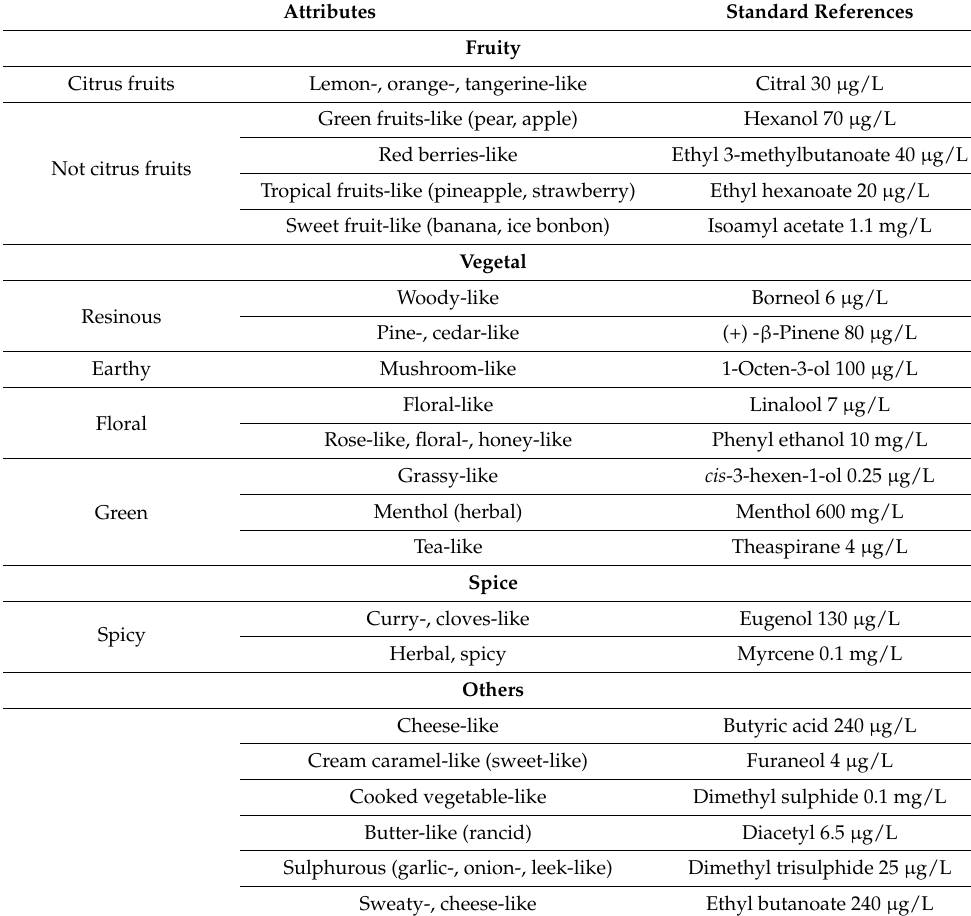
Table 1. Attributes, standard and hop references provided to panellists during training